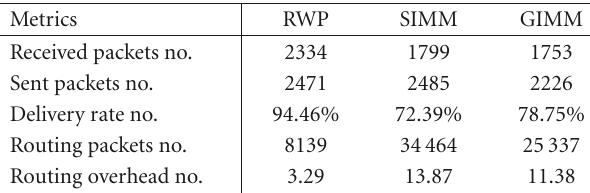
Table 4: The influence of mobility in the AODV protocol.